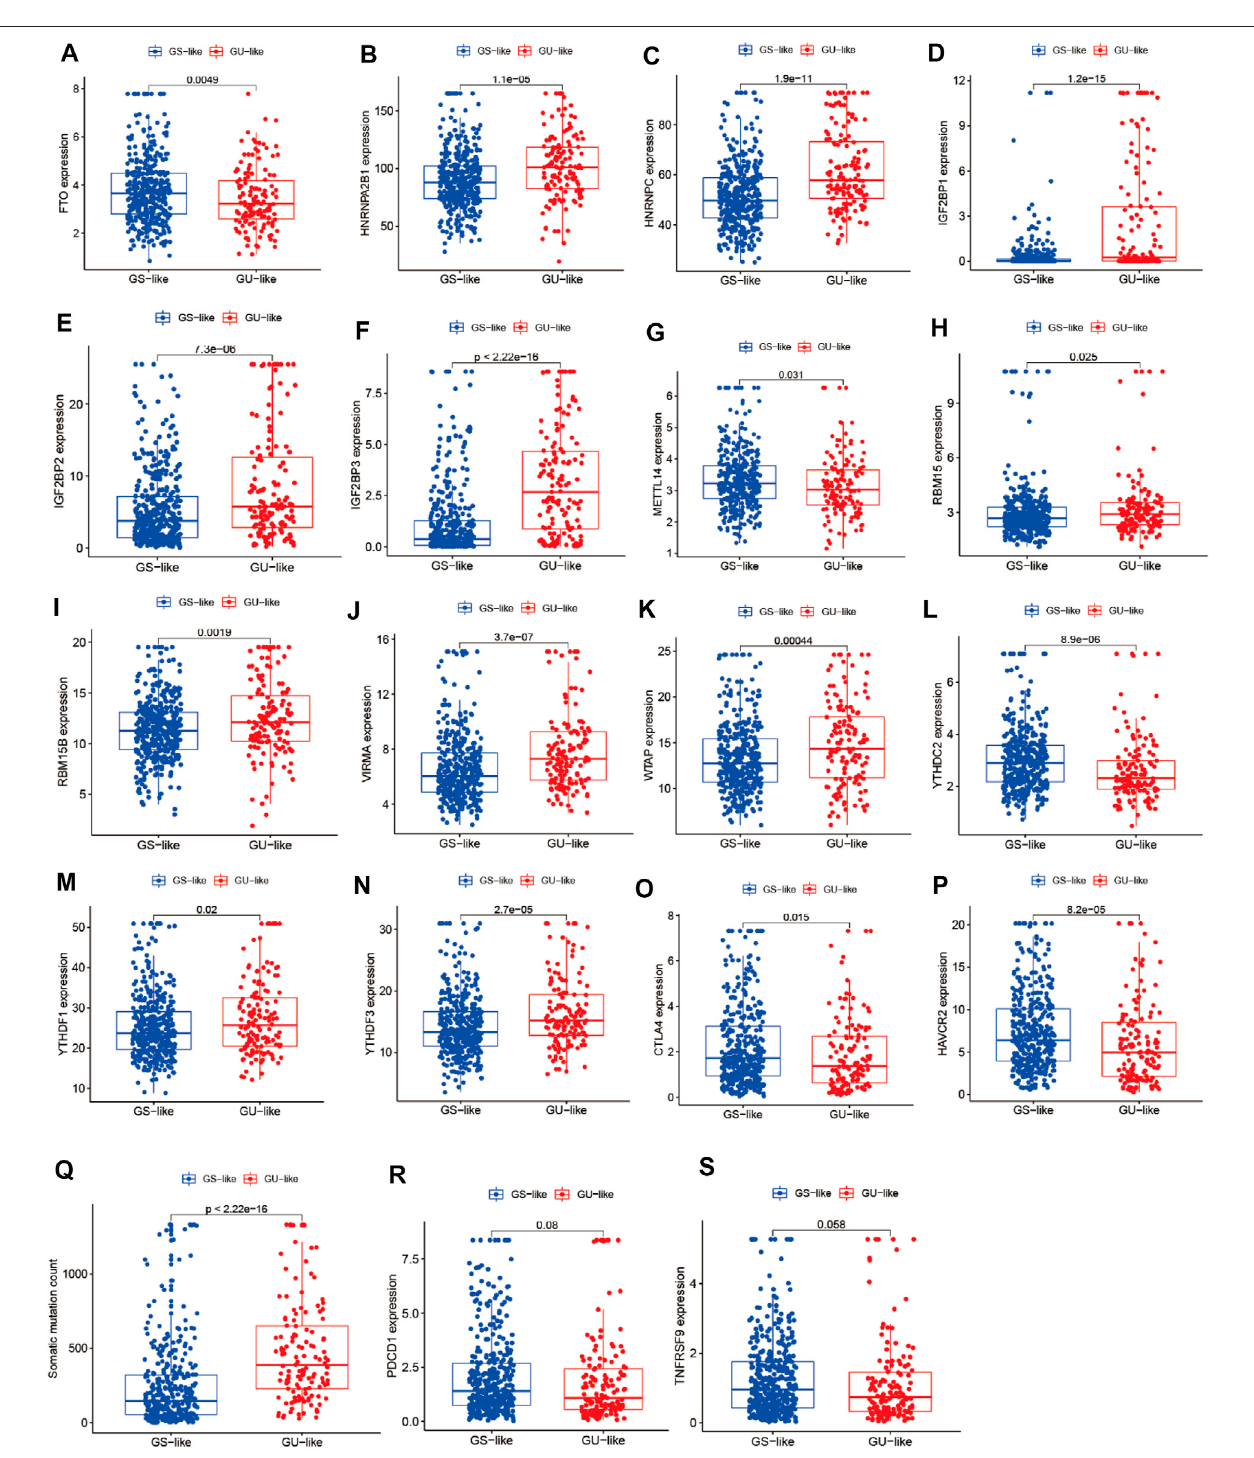
FIGURE 3 | Correlation analysis of LUAD clusters, expression of m 6 A regulators, CTLA4, HAVCR2, PDCD1, 4-1BB (TNFRSF9), and somatic mutation counts of LUAD. (A – N) Correlation analysis of LUAD clusters and expression of m 6 A regulators. (O – S) Correlation analysis of LUAD clusters and expression of CTLA4, HAVCR2, PDCD1, and 4-1BB (TNFRSF9). (Q) Correlation analysis of LUAD clusters and somatic mutation counts.